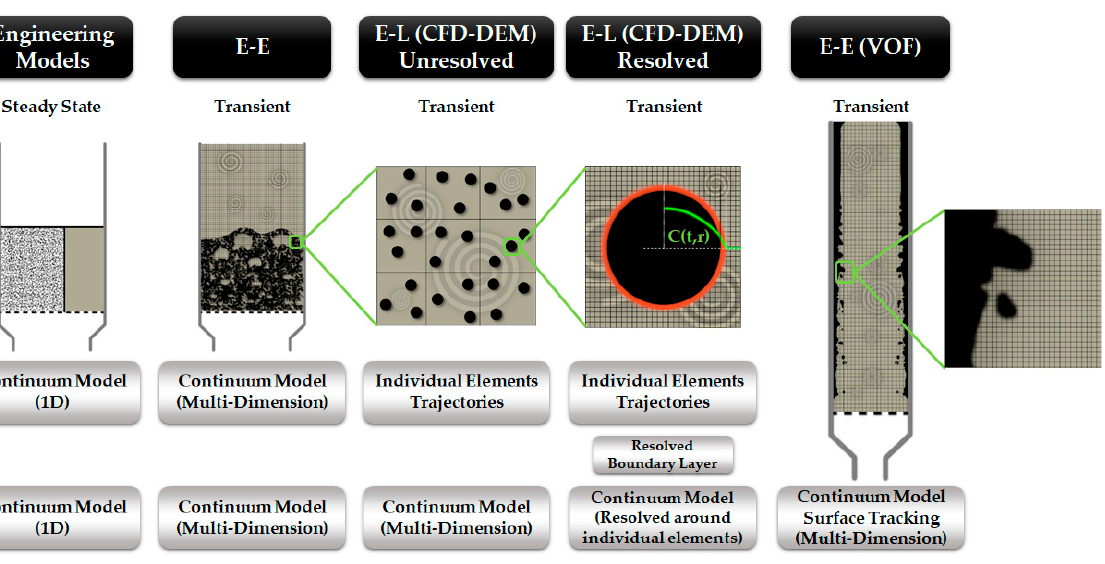
Figure 14. Illustration of different multi-phase flow modeling approaches for the fluidized bed technology (adapted from [169,288]).